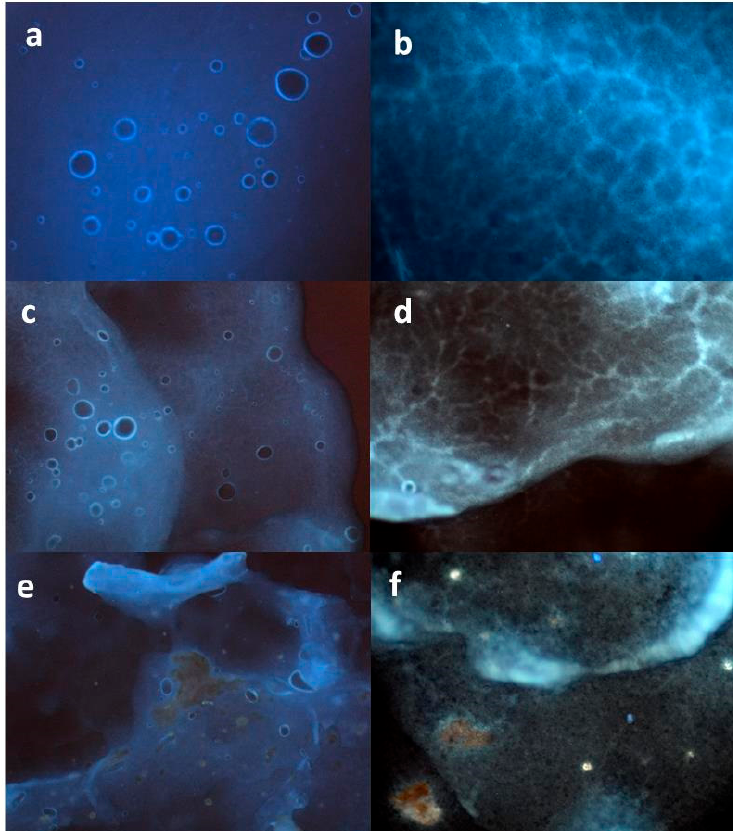
Figure 2. Fluorescence microphotographs of emulgel formulations ( a , b = blank emulgel; c , d = MTE-mp emulgel; e , f = raw MTE emulgel).